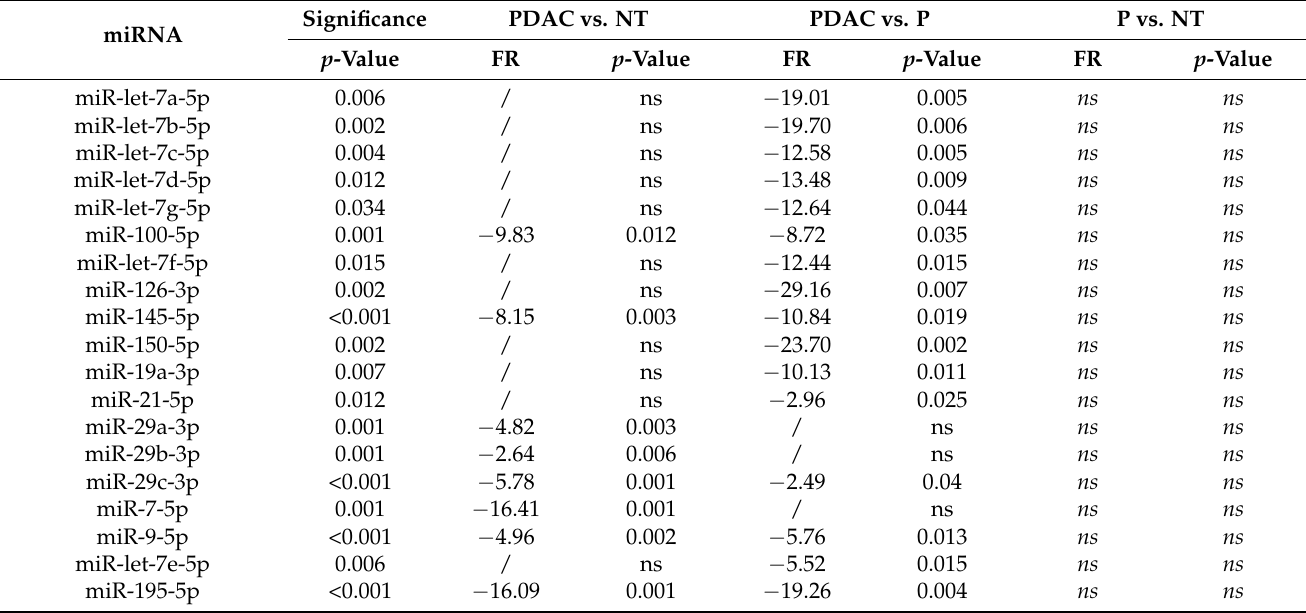
Table 3. Comparison of the levels of the miRNAs in PDAC, NT, and P. p -Values refer to Kruskal–Wallis test followed by pairwise comparisons. FR (fold regulation); ns (statistically not